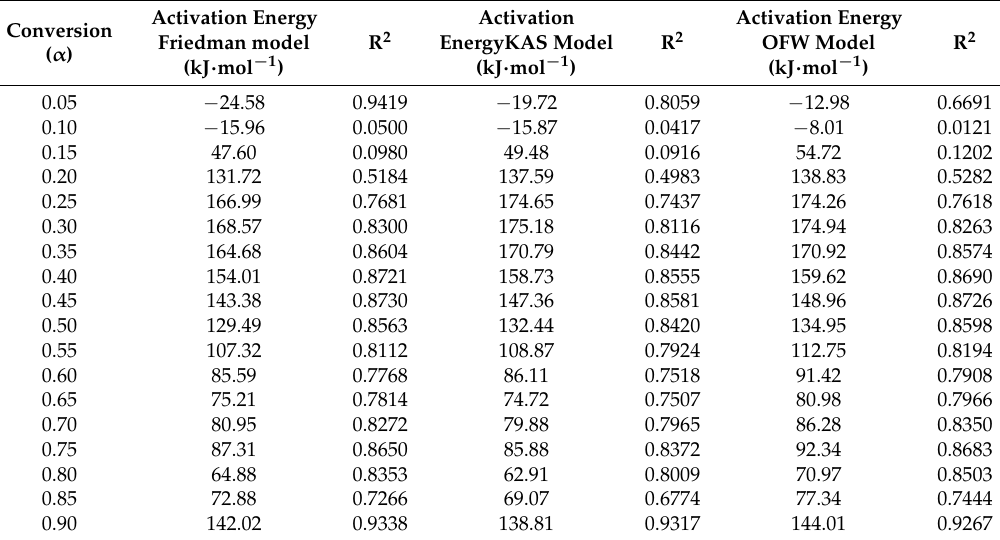
Table 3. Parameters of PT calculated by Kissinger–Akahira Sunose (KAS), Ozawa–Flynn–Wall (OFW), and